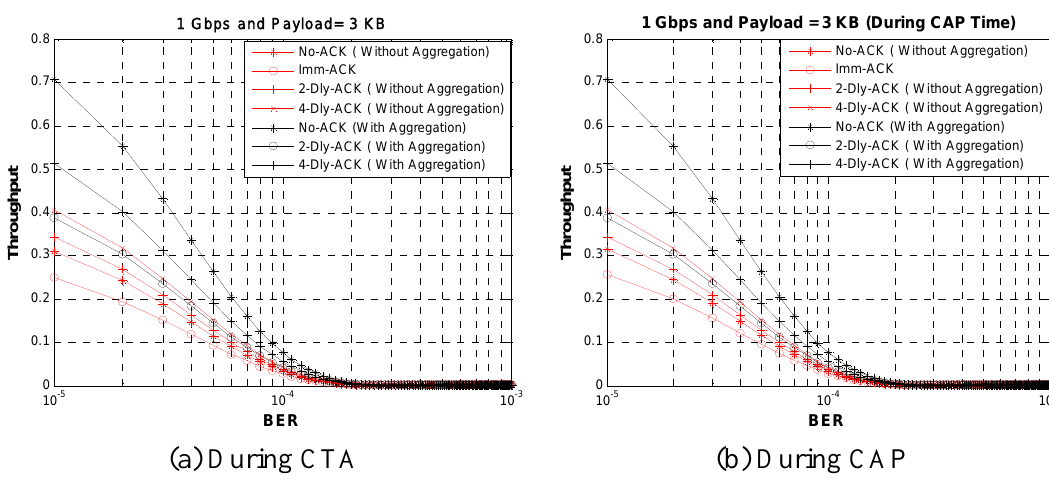
Figure 15. Throughput versus BER value with different ACK